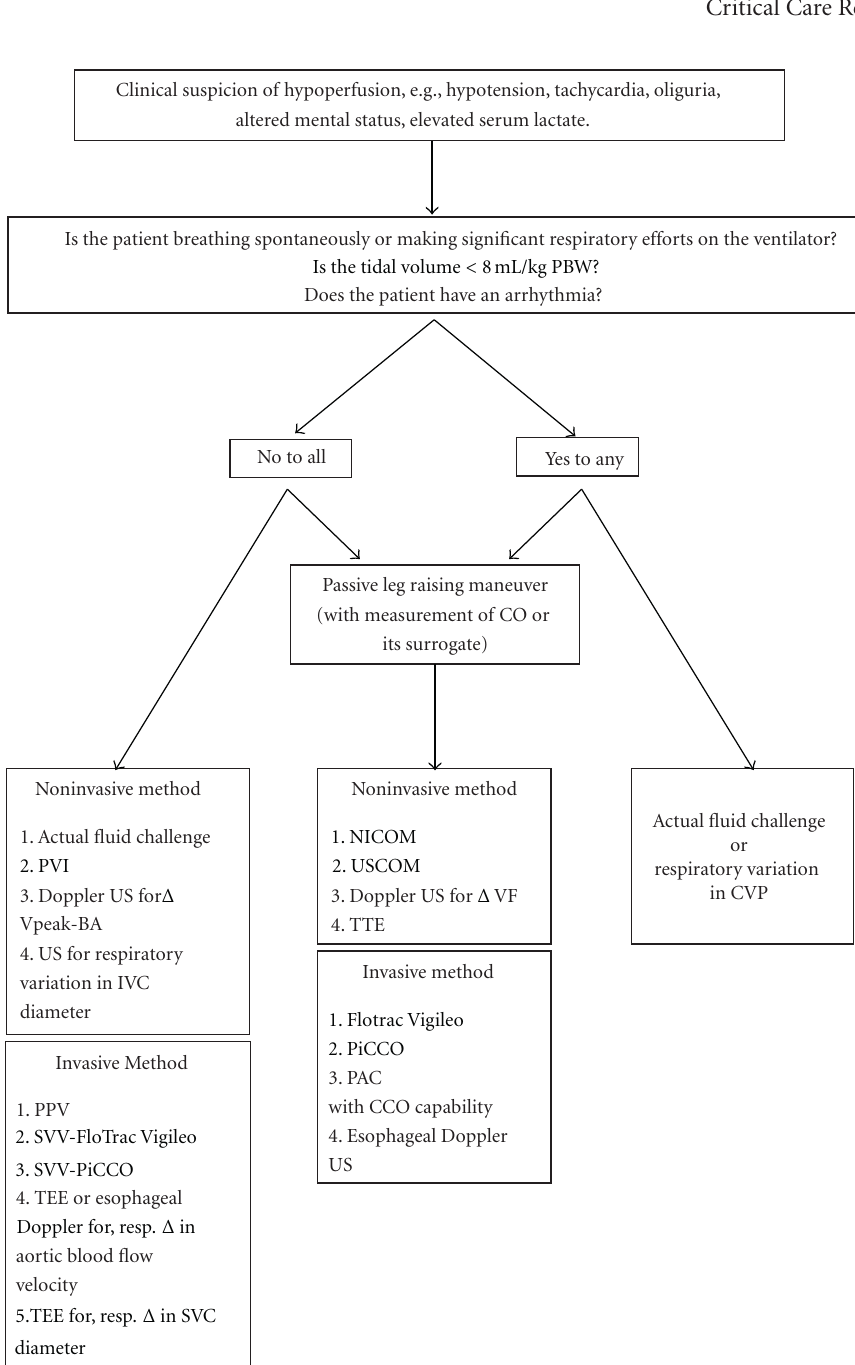
Figure 3: Approach to optimizing preload. PBW: predicted body weight, CO: cardiac output, PVI: pleth variability index, Δ V peak-BA: respiratory variation in peak brachial arterial blood flow velocity, US: ultrasonography, IVC: inferior vena cava, PPV: pulse pressure variation, SVV: stroke volume variation, TEE: transesophageal echocardiography, SVC: superior vena cava, NICOM: noninvasive cardiac output monitor, USCOM: ultrasonic cardiac output monitor, Δ VF: change in femoral artery blood flow velocity, CCO: continuous cardiac output, TTE: transthoracic echocardiography, PAC: pulmonary artery catheter, CVP: central venous pressure.